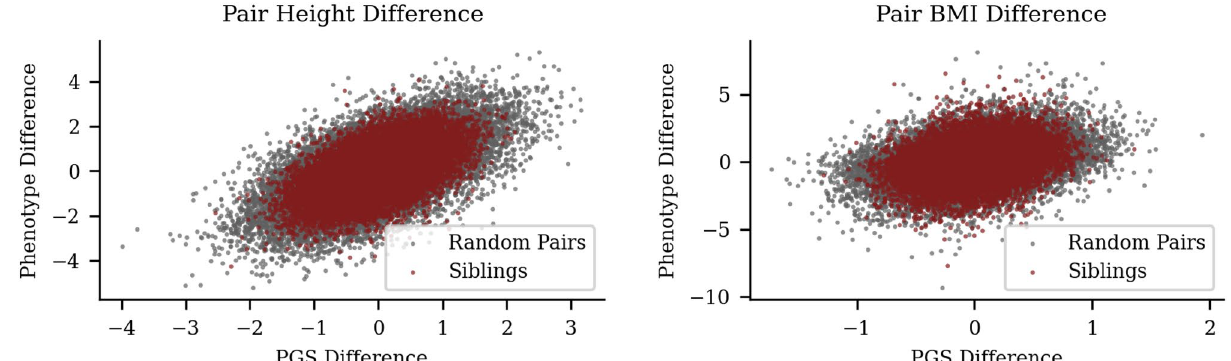
Figure 2. Reduced, but still significant, variation among siblings relative to general population. UKB sibling pair vs unrelated pair differences in phenotype (vertical axis) and corresponding difference in PGS (horizontal axis). The left and right panels are height and BMI,